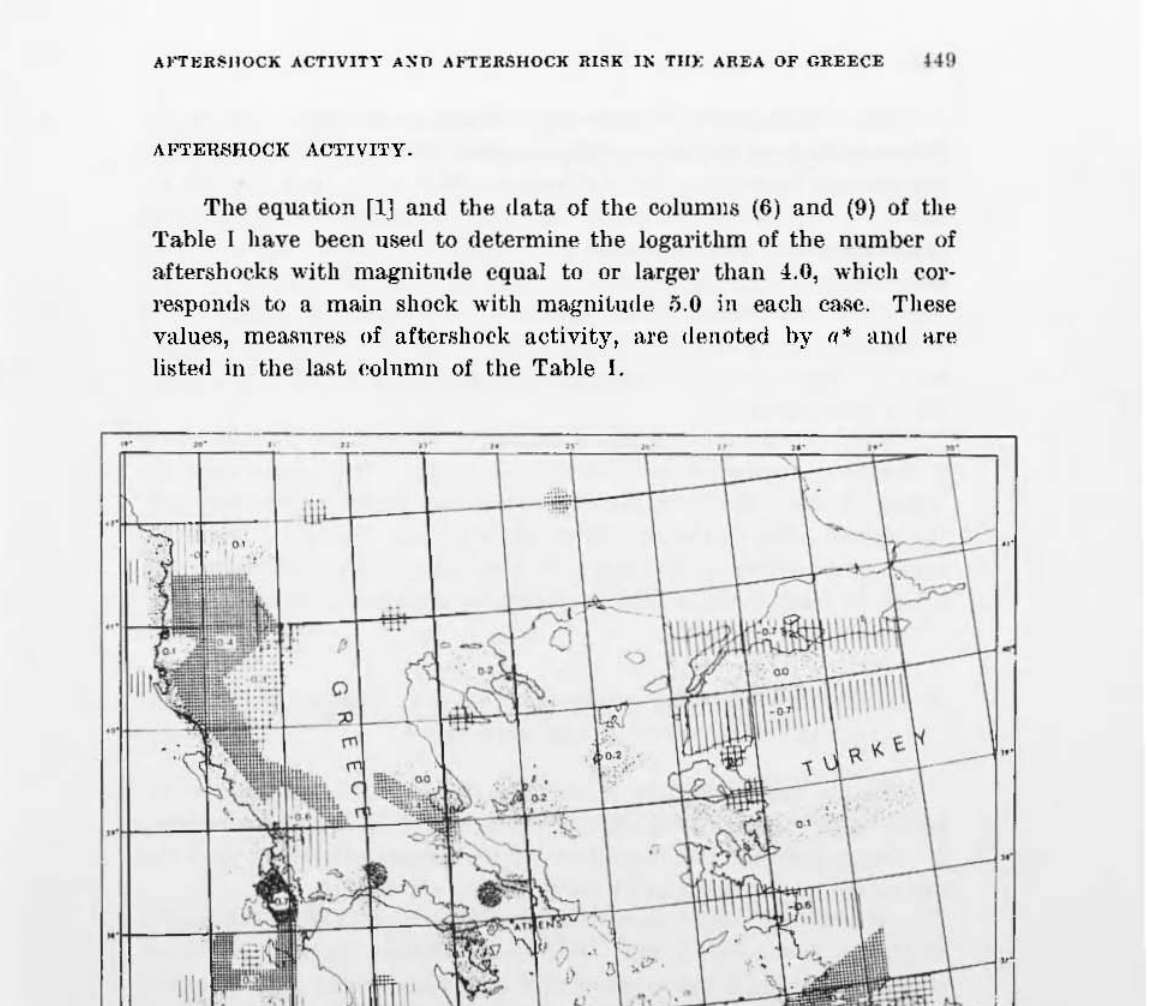
Fig. 3. - Geographical di ... trihution of the aftert<lwck activity in tlle area of